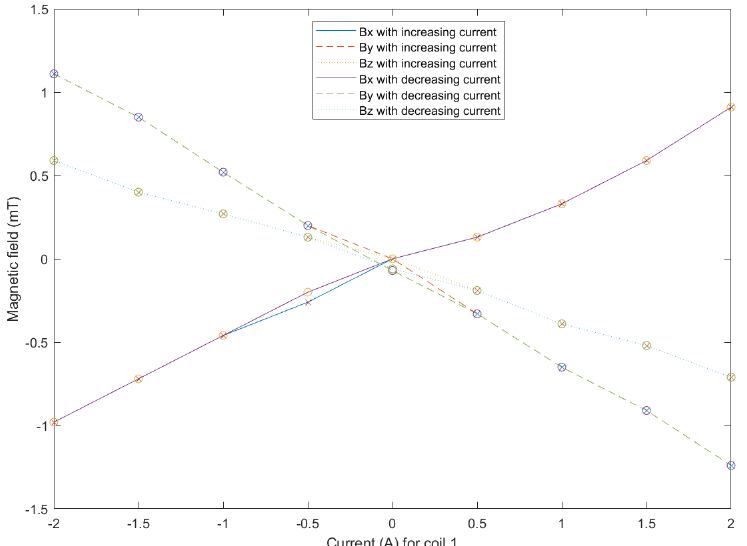
Figure 24. Hysteresis curve for the magnetic field at the center of the workspace as a function of current ( − 2 A to 2 A) actuating coil 1. Shape x in the curve denotes the data for increasing current, and shape o denotes the data for decreasing